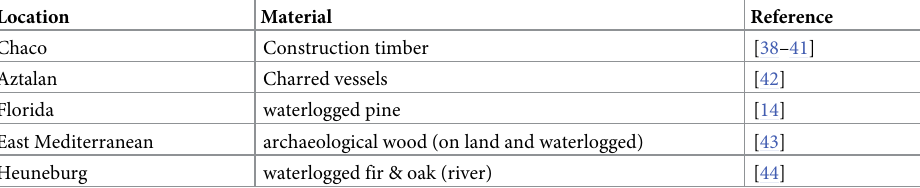
Table 1. Overview of the applications of Sr isotopic analysis on wood in